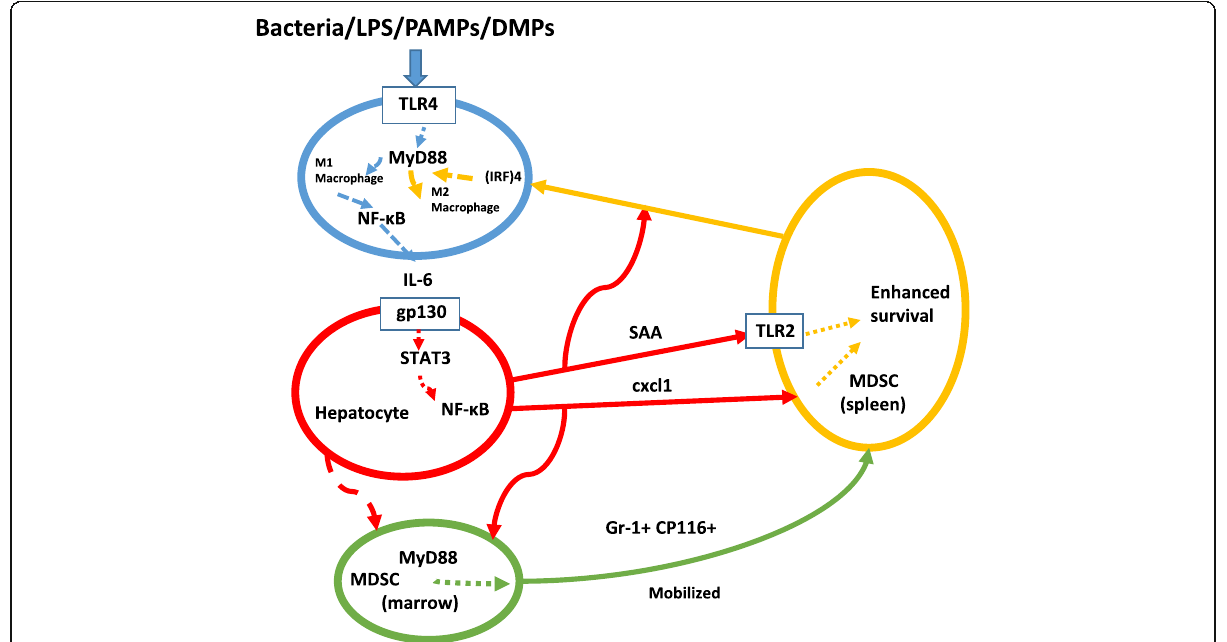
Fig. 7 Proposed relationships between cytokines, chemokines and participating cells in APR consistent with current data. Note 3 distinct cell types: 1) macrophages, 2) hepatocytes, 3) myeloid-derived suppressor cells [MDSC]. MDSC can be mobilized from bone marrow and undergo further differentiation in spleen and